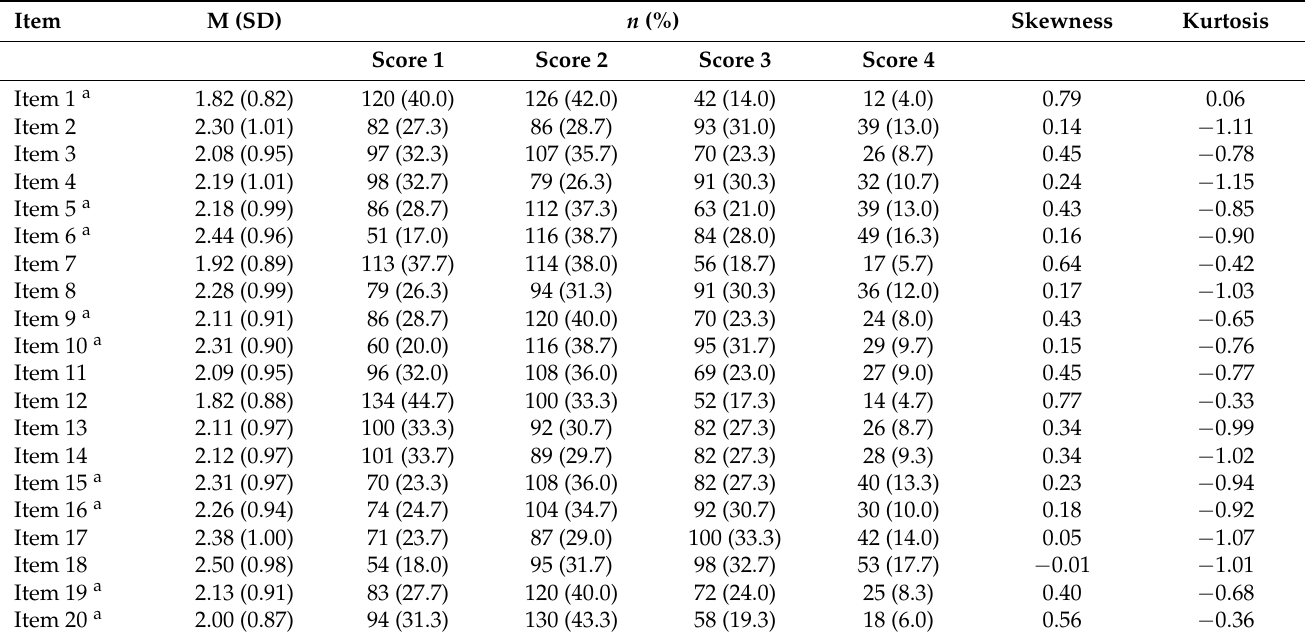
Table 2. Score distributions of the 20 items comprising the UCLA Loneliness Scale, Version 3 ( n = 300).